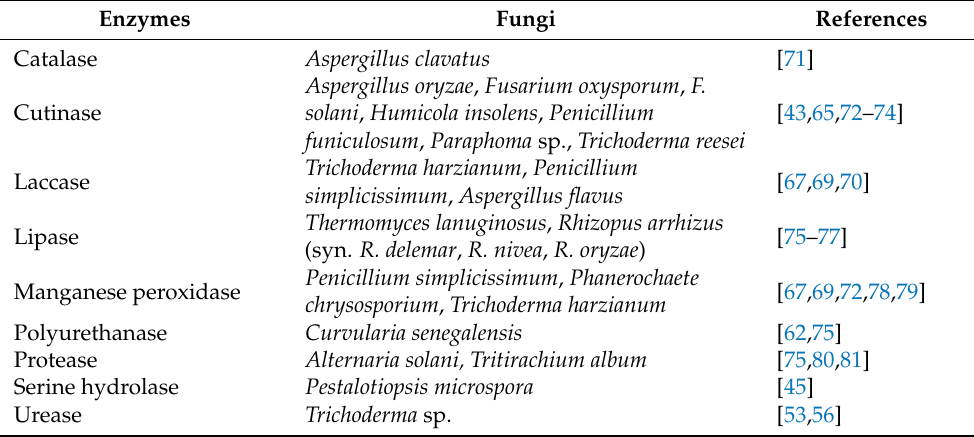
Table 2. Fungal enzymes involved in plastic